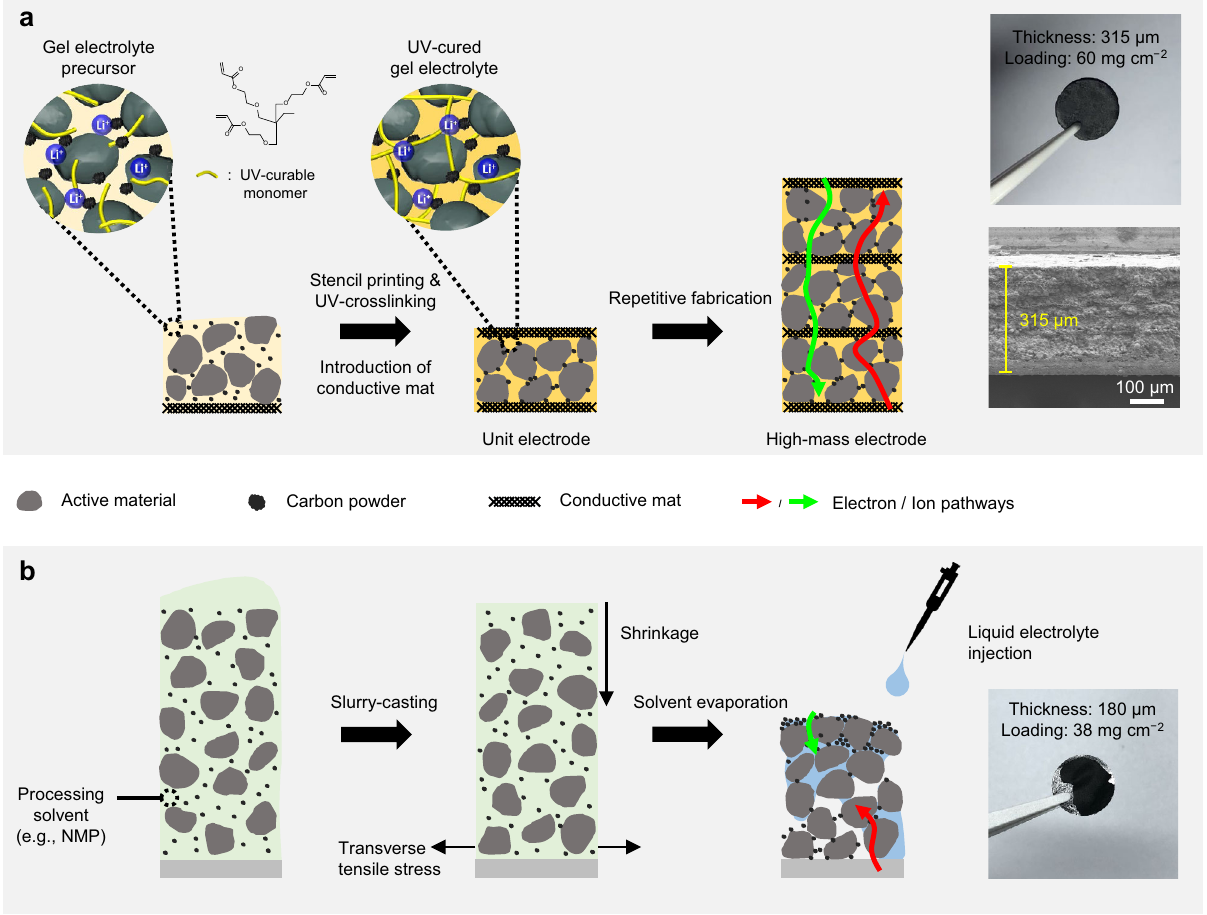
Fig. 1 Schematic representation of the structural design and fabrication procedure of high-mass-loading electrodes. a BNQS electrode, along with its photograph and cross-sectional SEM image. b Control electrode fabricated by means of a slurry-cast